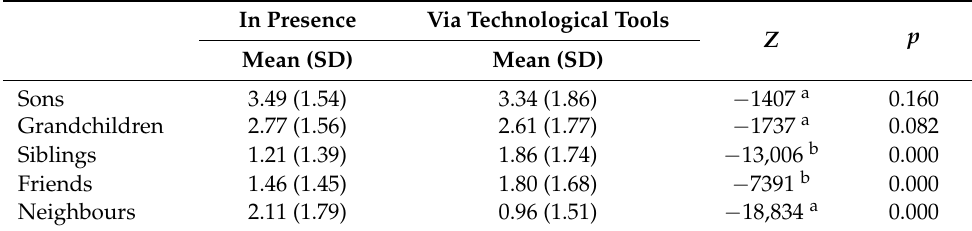
Table 3. Attendance of the network of significant relationships during the COVID-19 outbreak in the presence and at a distance. In Presence Via Technological